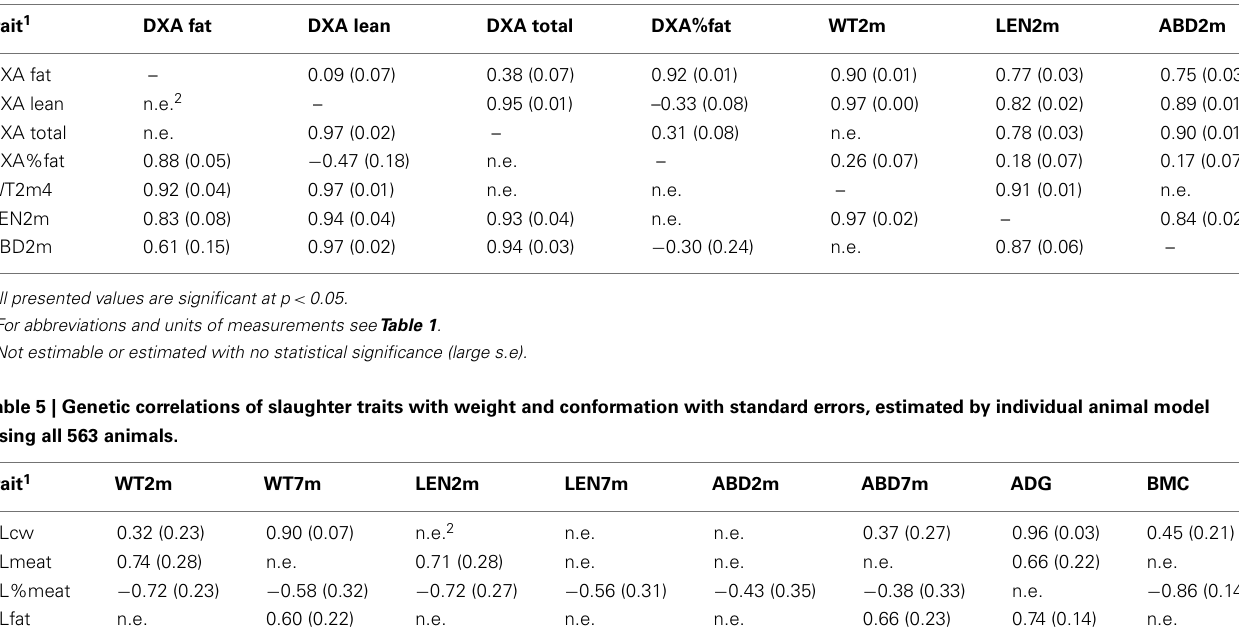
Table 4 | Genetic (above the diagonal) and phenotypic (below the diagonal) correlations between DXA and weight and conformation traits with standard errors, estimated by individual animal model using all 563 animals.